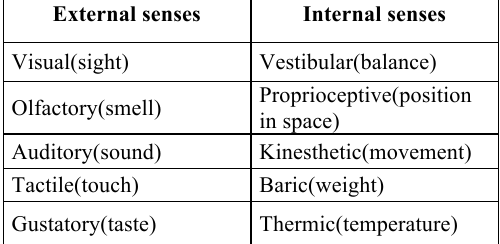
Figure 1. Phototype of Seesaw